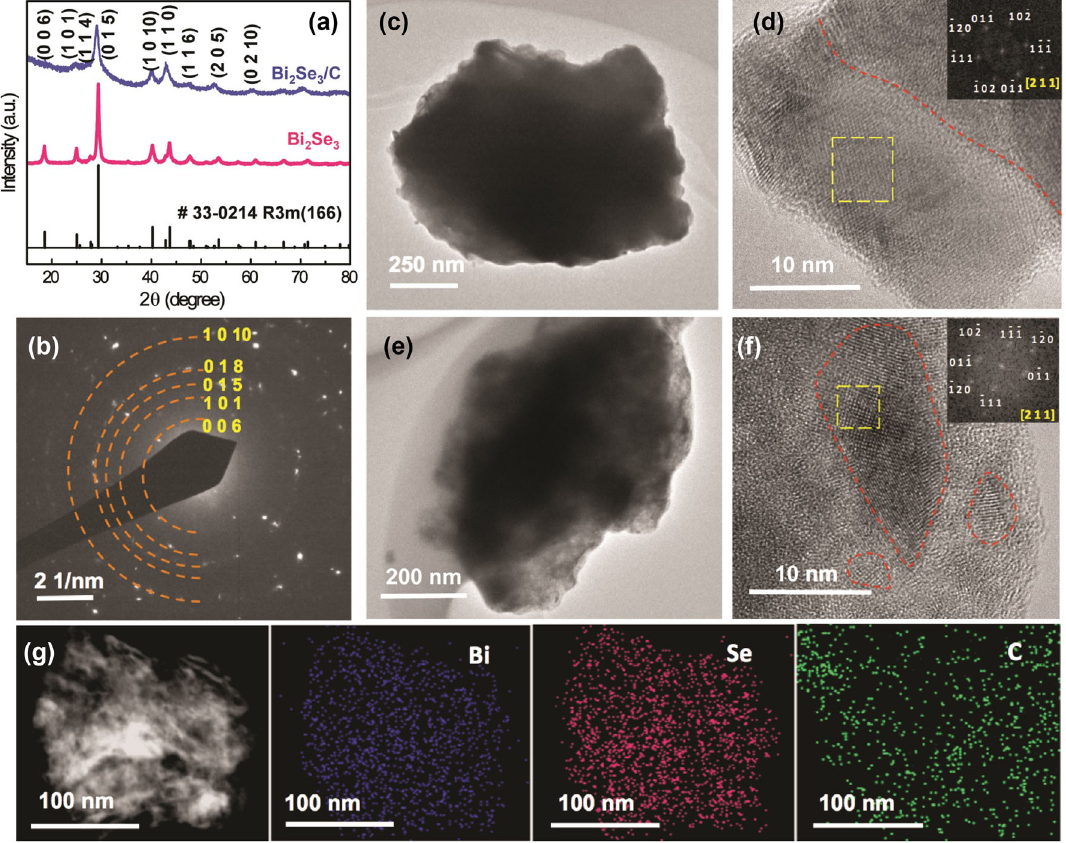
Fig. 1 a XRD patterns of as-synthesized Bi 2 Se 3 and Bi 2 Se 3 /C. b The diffraction pattern of Bi 2 Se 3 . c Low- and d high-resolution TEM images of Bi 2 Se 3 . e Low- and f high-resolution TEM images of Bi 2 Se 3 /C. g Scanning TEM (STEM) image and its corresponding elemental (Bi, Se, and C)